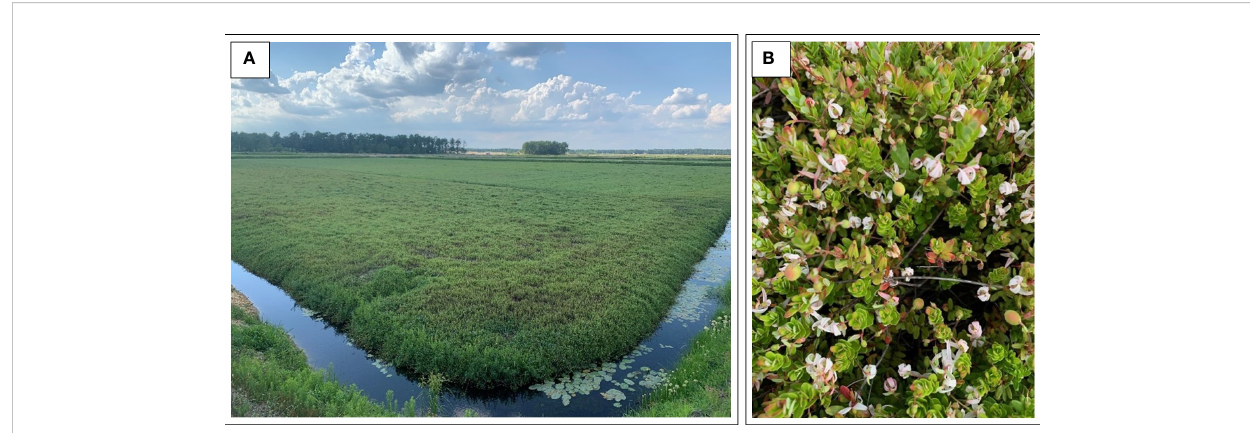
FIGURE 1 The American cranberry ( Vaccinium macrocarpon Aiton). A cranberry bed in a commercial farm (A) , and a close-up of the cranberry plant during bloom and early fruit set (B)